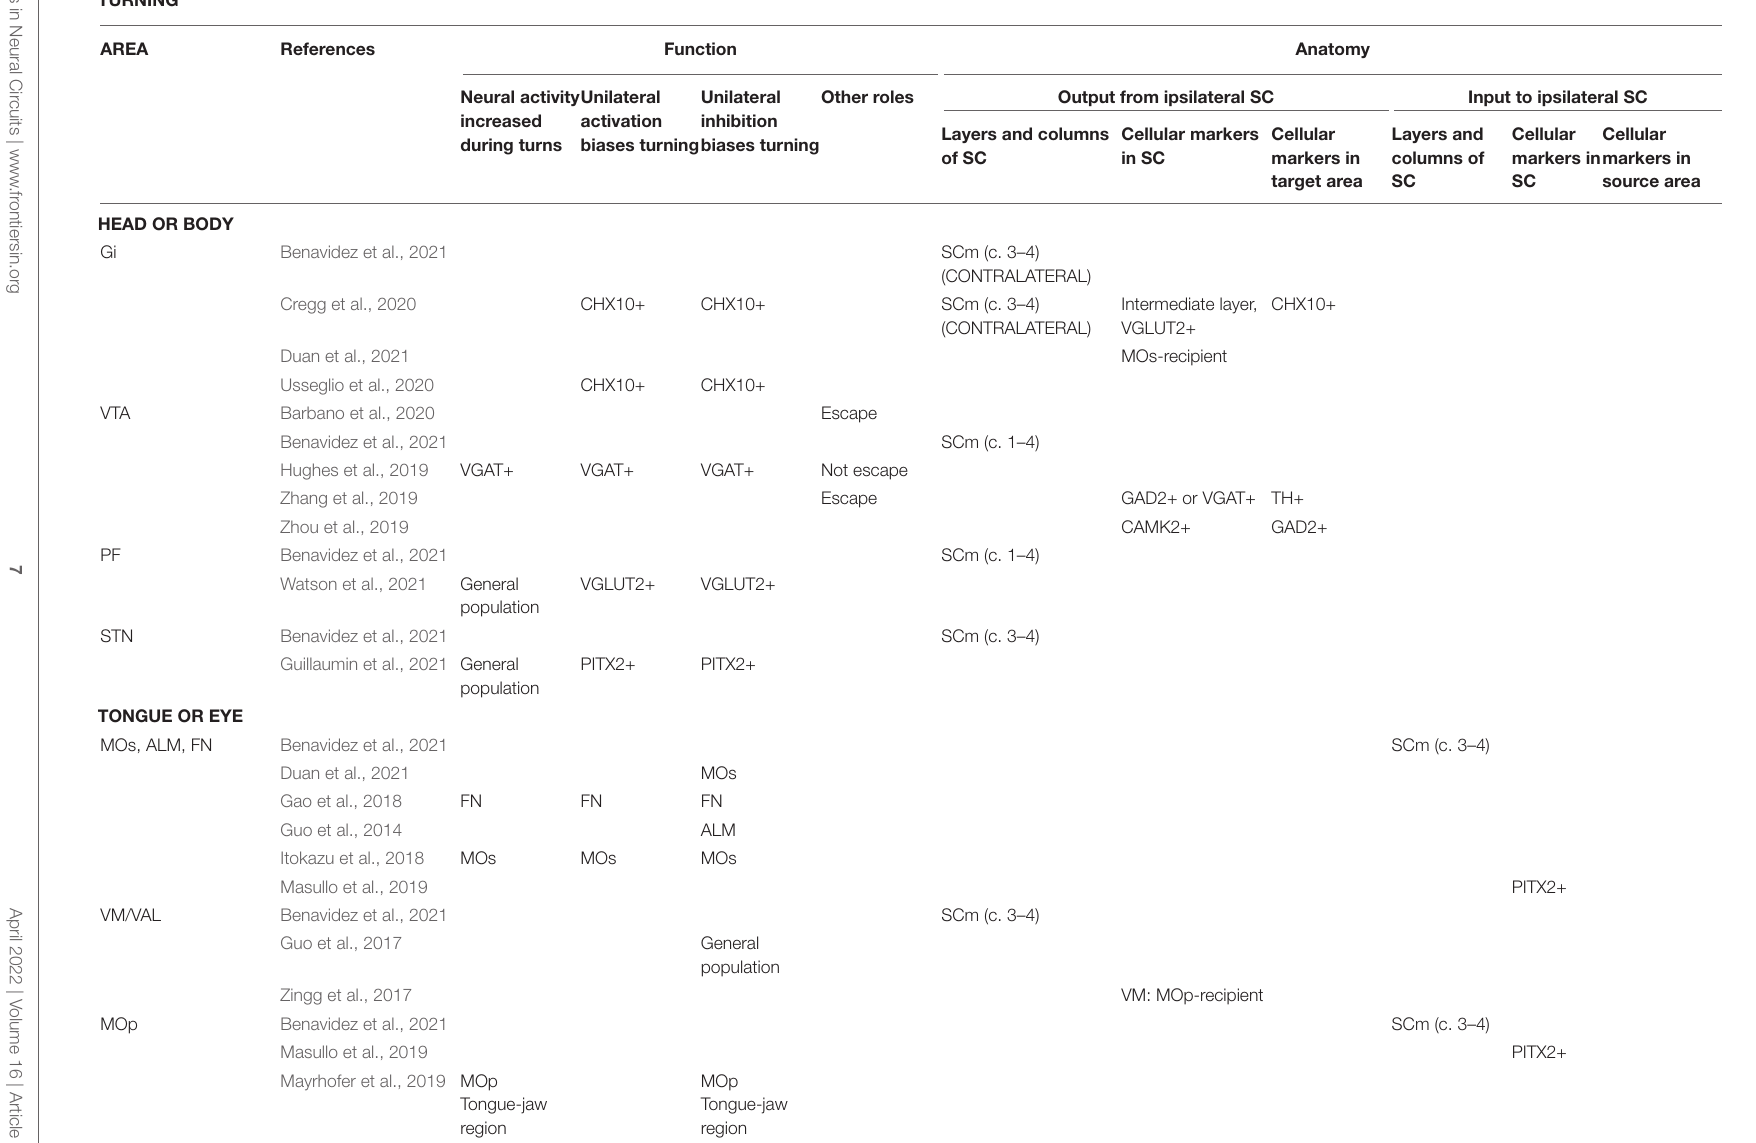
TABLE 2 | Areas reported to be involved in the production of